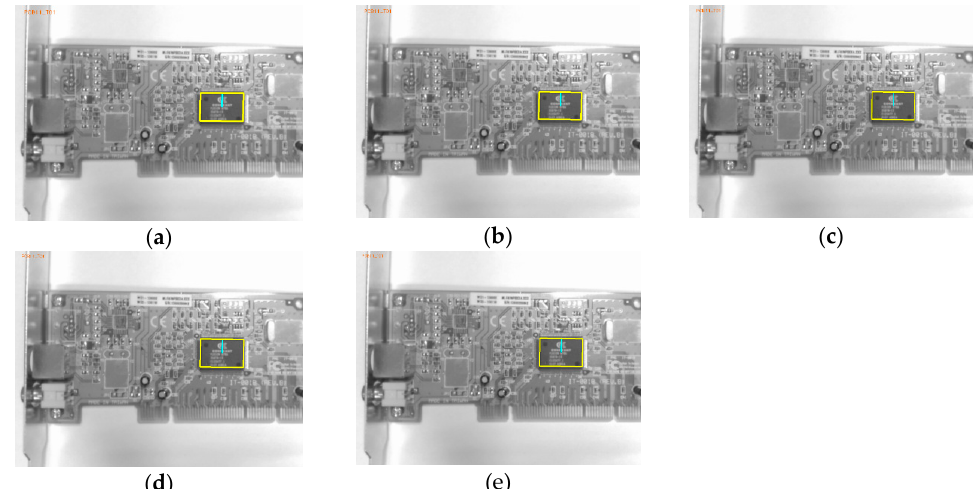
Figure 9. Comparison of the scale errors on 5 scale factors.